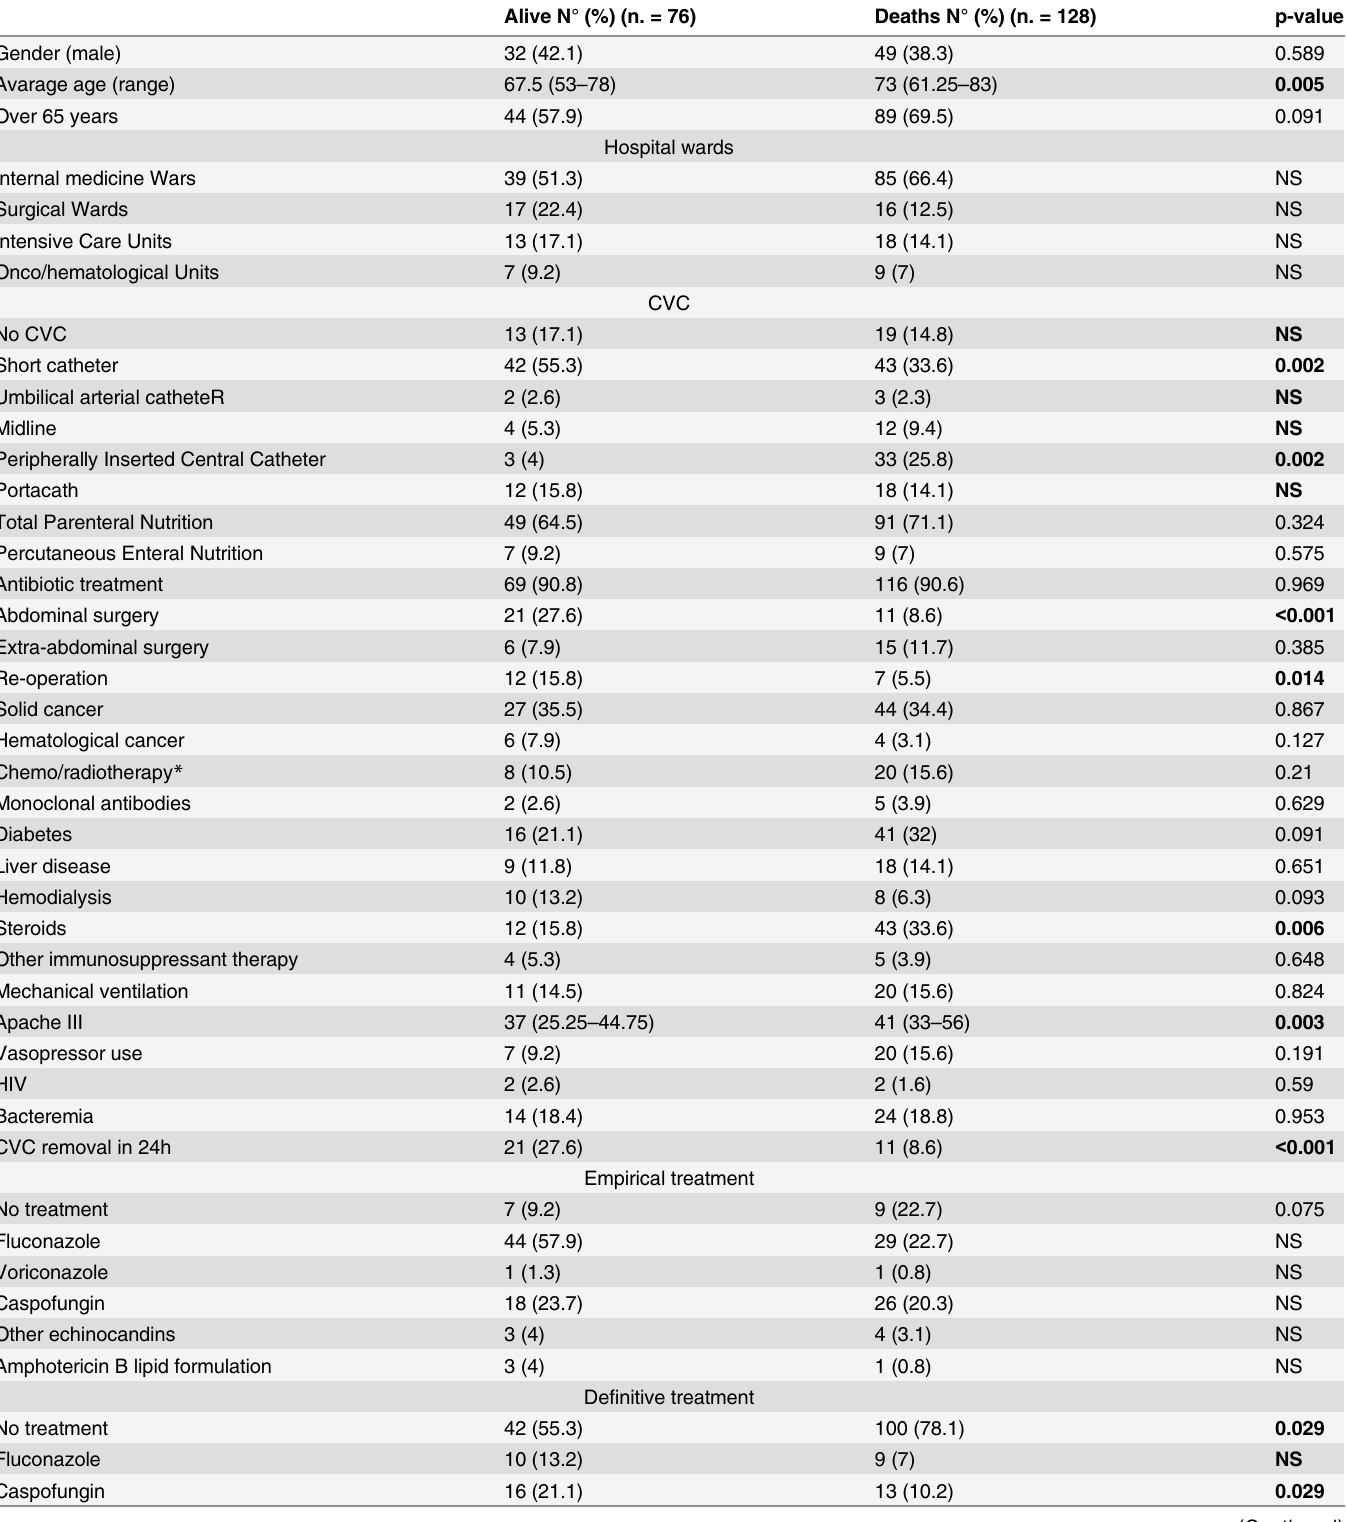
Table 4. Characteristics of survivors (N = 76) compared with patients with candidemia who died (N =